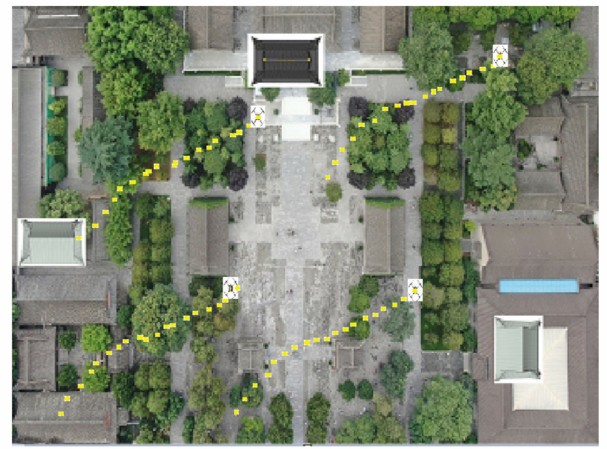
Figure 8. UAV trajectory (experimental random scenario).